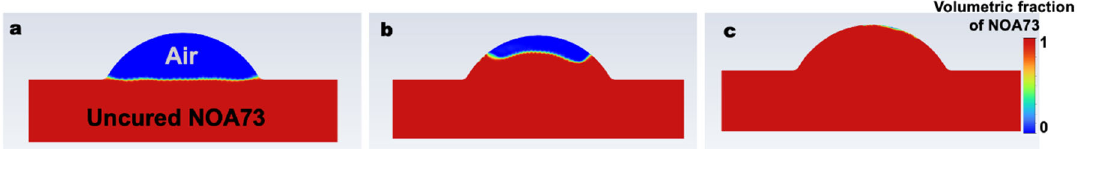
Figure A1. Fluid dynamic simulation results of uncured NOA73: ( a ) initial stage of uncured NOA73 film and typical air in nanocup; ( b ) a mid ‐ time step when NOA73 continues rising, air exits through top outlet boundary; and ( c ) NOA73 fully occupies the nanocup.